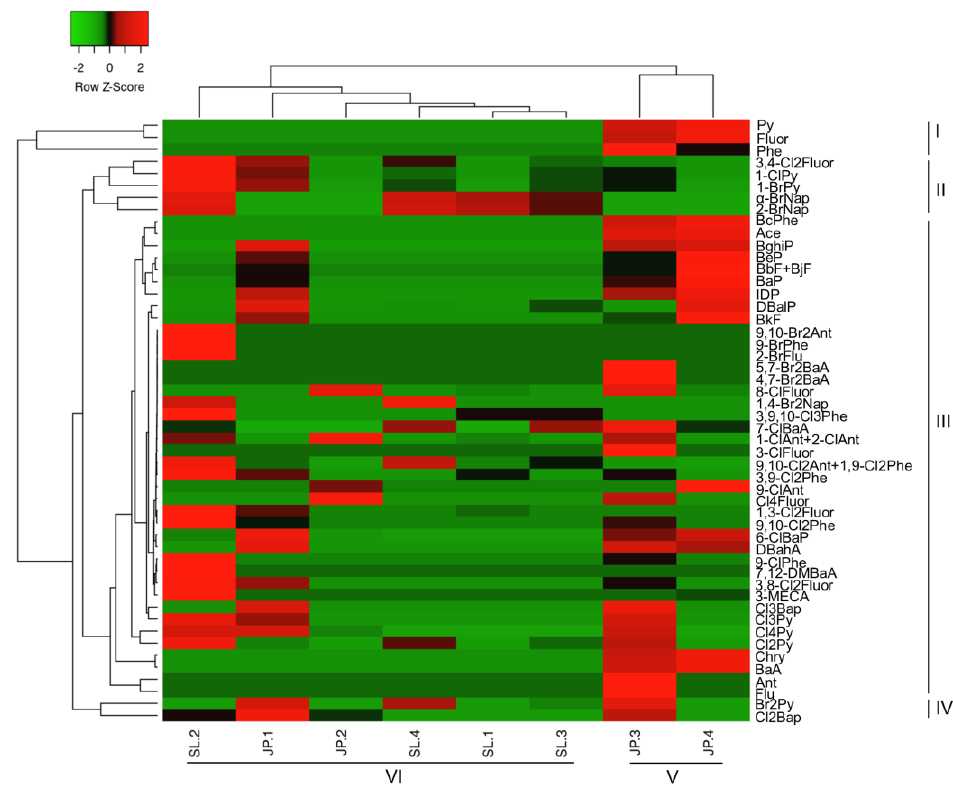
Figure 3. Cluster heat map showing the concentrations of detected PAHs, ClPAHs, and BrPAHs in milk powder samples from Sri Lanka and Japan. The relative concentrations of each congener in the milk powder samples are shown as intensities illustrated using the scales shown.